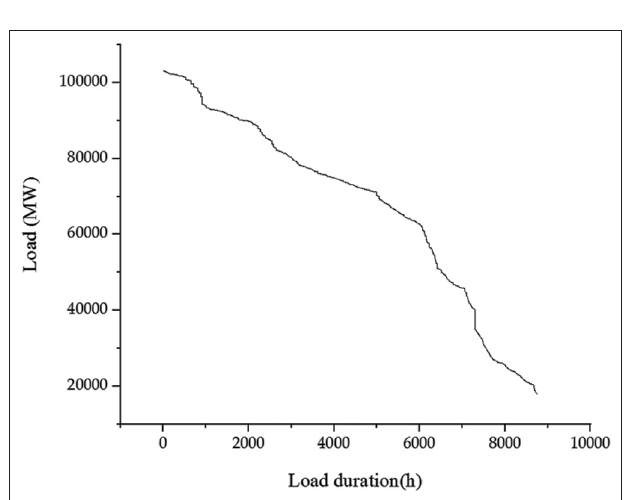
FIGURE 4 | Annual sustained load curve of